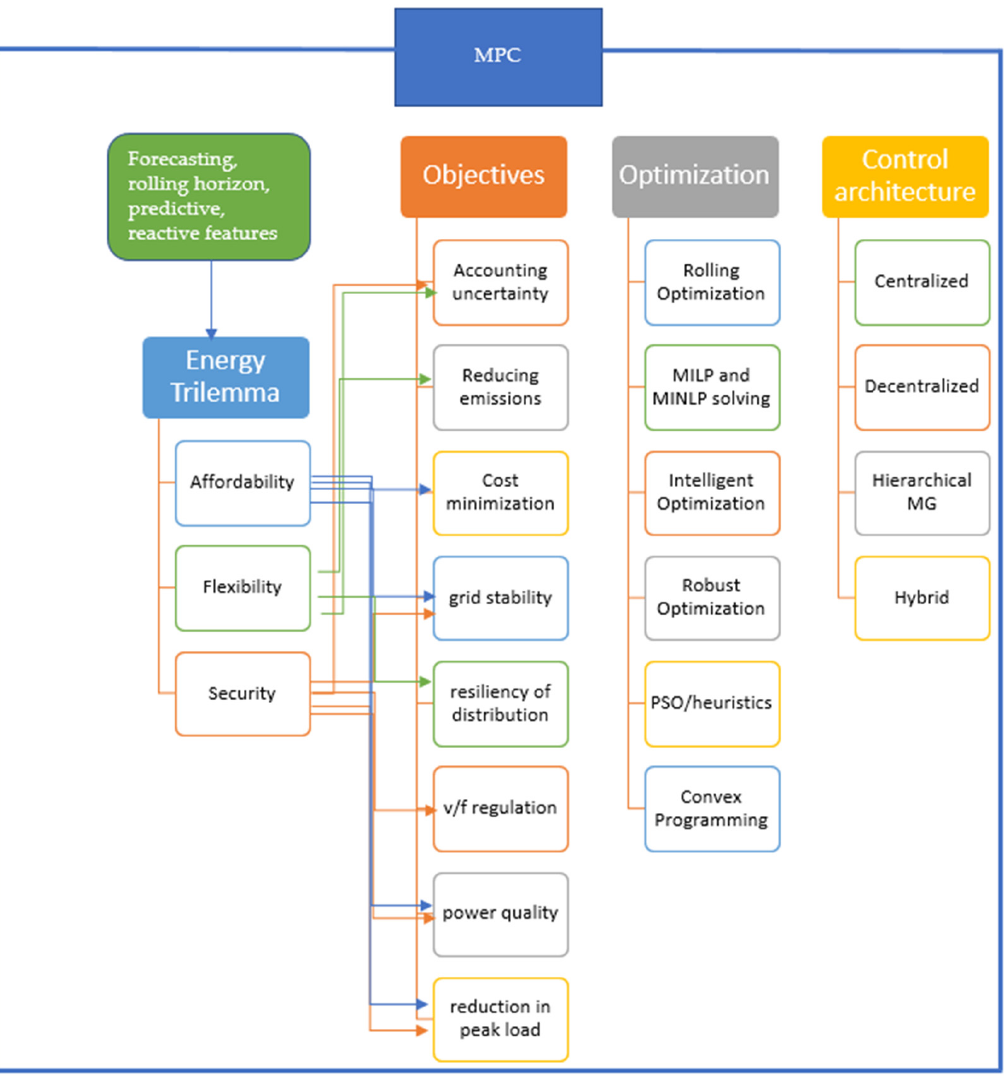
Figure 9. Constituents of MPC for achieving energy trilemma aspects in MGs-EMS.